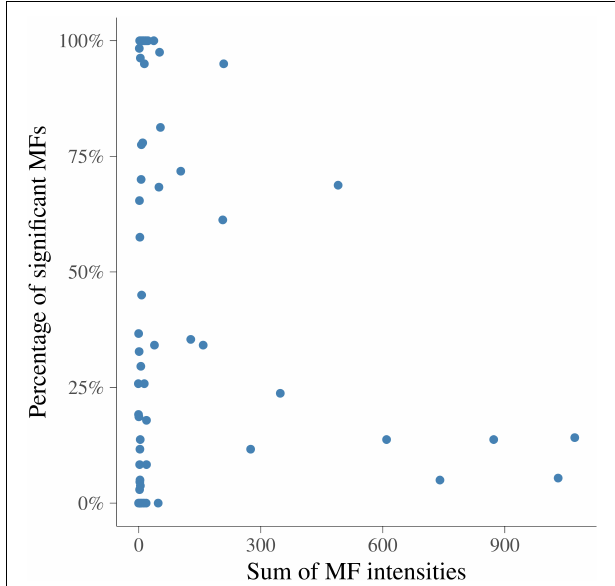
FIGURE 4 | Relationship between the sum of metabolomic feature intensities and the proportion of significant heritable metabolomic features in 100 intervals. x -axis is the sum of metabolomic feature intensities in each interval, y -axis is the percentage of metabolomic feature having heritabilities significantly different from